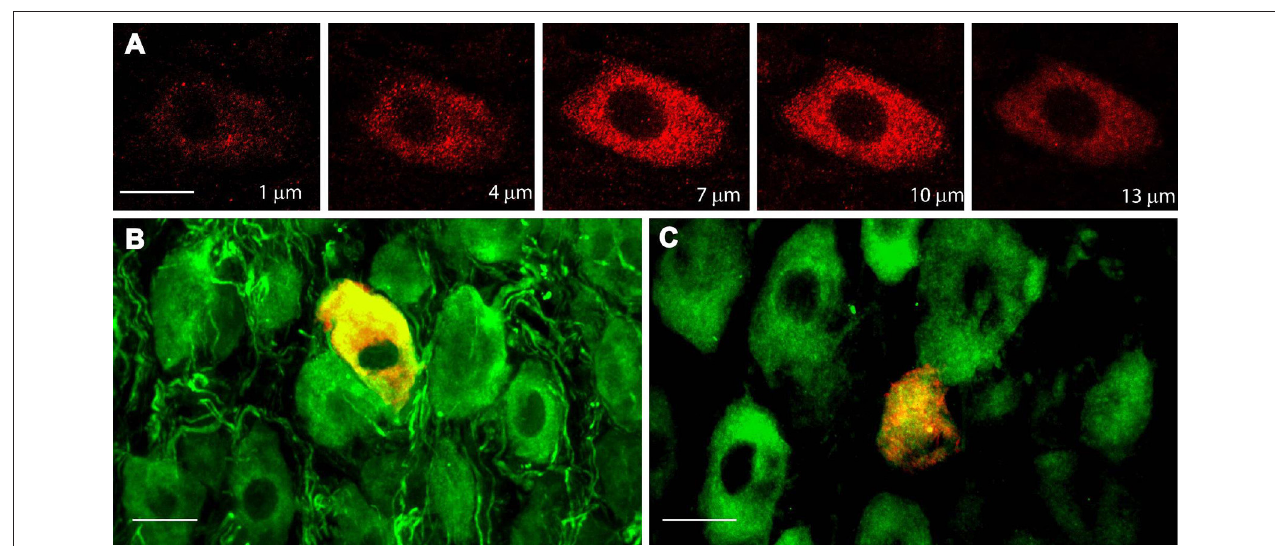
FIGURE 2 | TrkB-Fl is non-uniformly expressed in the cytoplasm of ganglionic neurons, which co-express tyrosine hydroxylase or p75NTR. (A) TrkB immunolabeling (red) occurred in clusters throughout the cytoplasm of ganglionic neurons, as shown in these serial confocal optical 1- µ m sections (z-axis) of SCG neurons. TrkB-Fl (red) was co-expressed with TH- (B) and p75NTR-IR neurons (C) . Scale bar = 10 µ m.